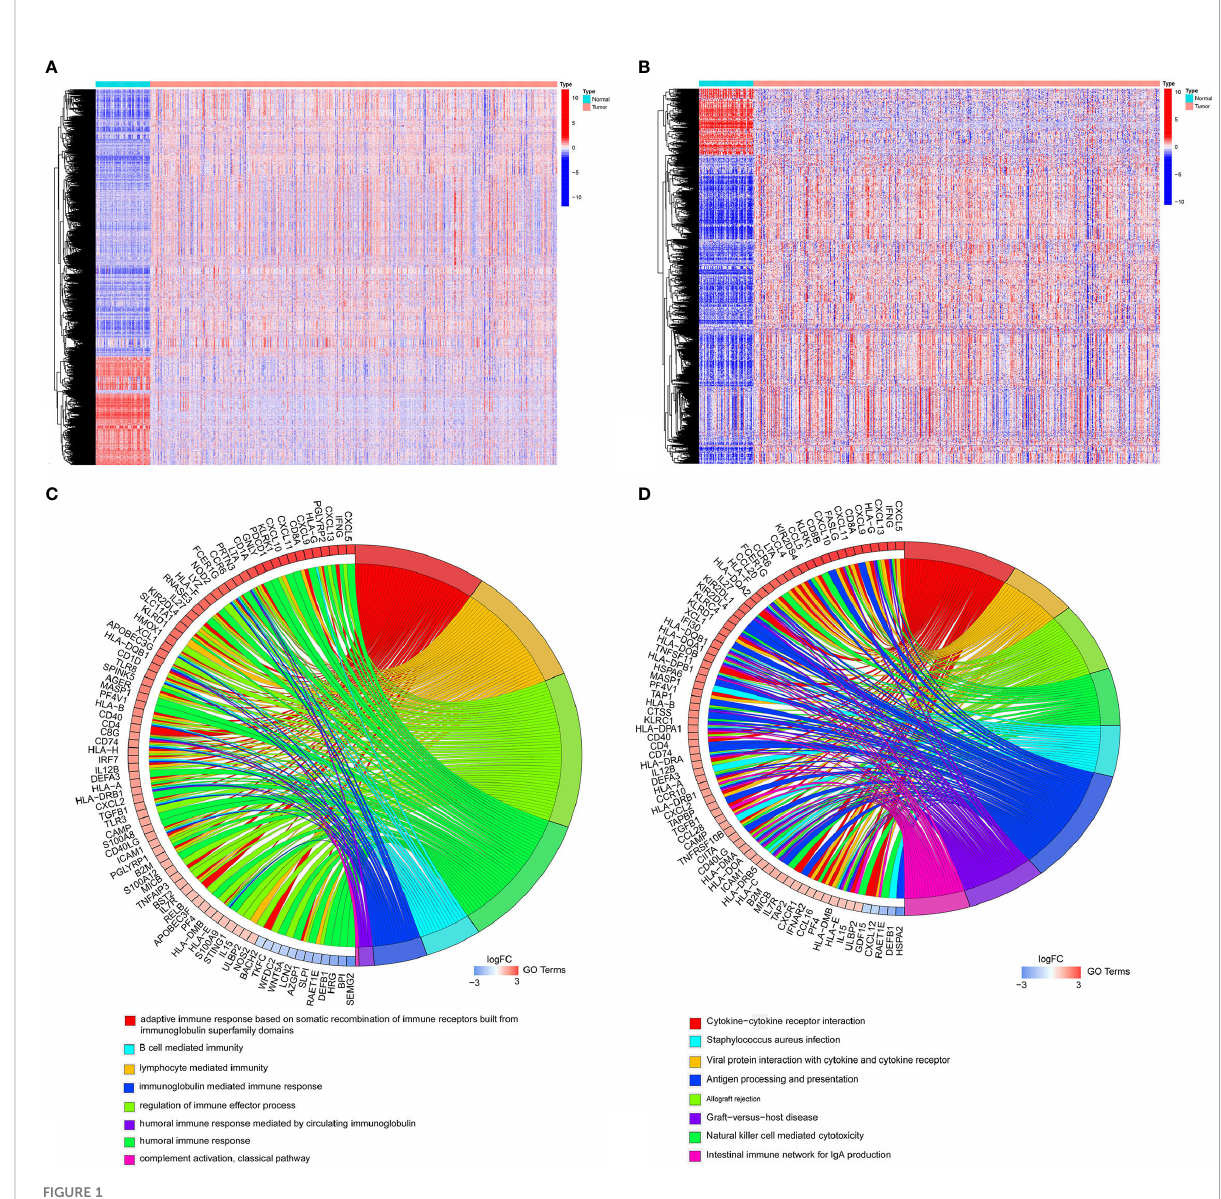
FIGURE 1 (A) Heatmap showing 1,909 genes downregulated and 4,903 upregulated in tumor samples by analyzing TCGA cohort. (B) Heatmap showing 166 immune-related genes downregulated and 780 immune-related genes upregulated in tumor samples. (C, D) . The top10 GO and KEGG terms by analyzing 946